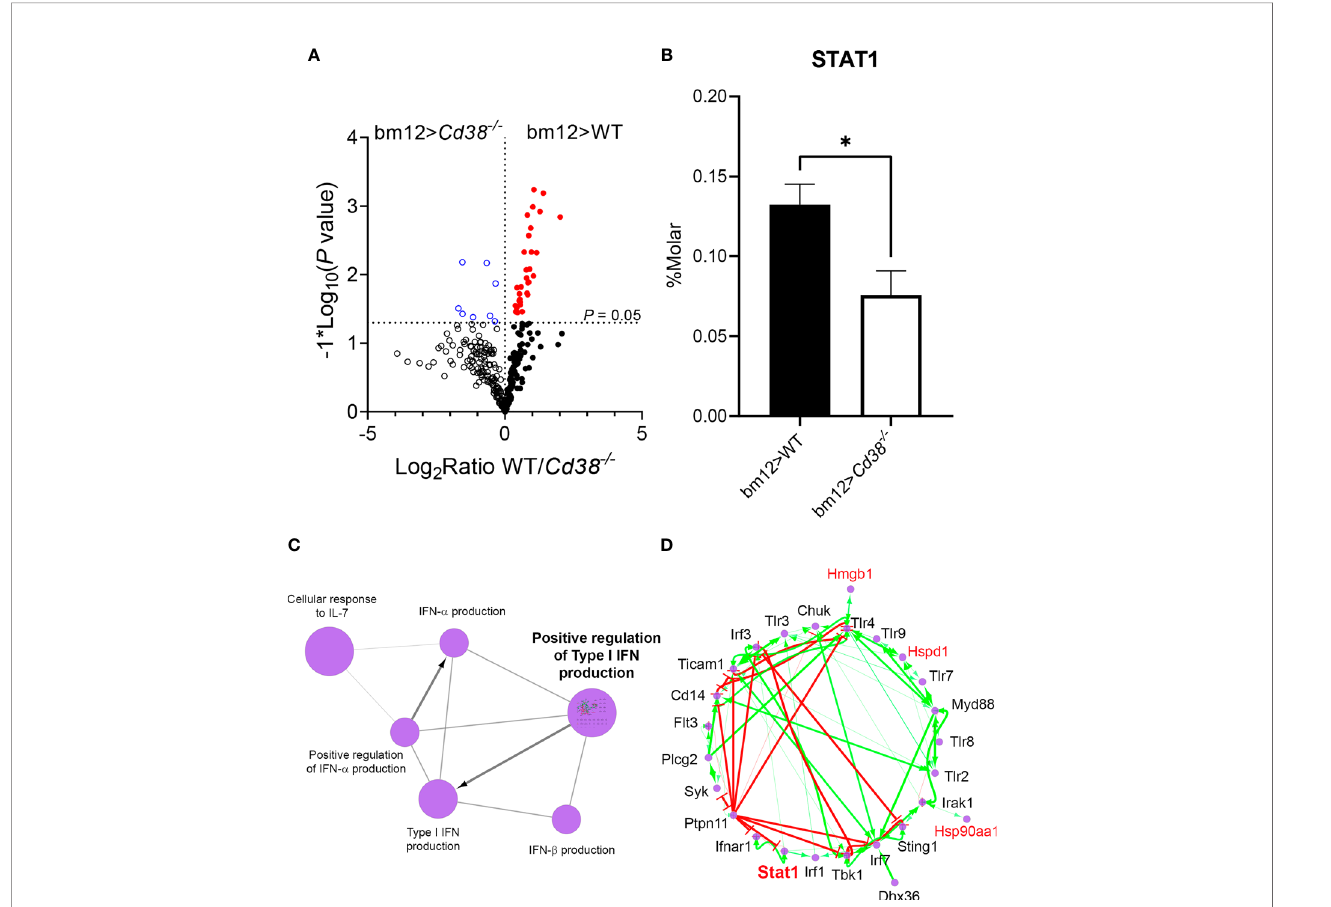
FIGURE 8 | (A) Volcano plots showing the differences in protein abundance in spleens of bm12> Cd38 − / − mice (open blue circles, upper left quadrant) relative to bm12>WT mice (closed red circles, upper right quadrant), 2 weeks after the adoptive transfer. Each circle denotes a different protein, and those above the horizontal dotted line showed statistical signi fi cant differences in abundance between mice. P < 0.05. (B) Histogram graph showing STAT1 protein abundance in spleens from bm12> Cd38 − / − versus bm12>WT mice at 2 weeks. Histograms represent the mean ± SEM, and the P -values are for unpaired t -test. Proteomic data shown in panels (A, B) are from two biological replicas per mouse type and three technical replicas per sample. (C) Functionally grouped network of GO terms/pathways and genes are visualized using the ClueGO/CluePedia application. Note that in this application the protein accession numbers of the identi fi ed proteins are transformed to their gene names. Terms (large purple circles) are linked based on k score ( ≥ 0.3). Edges show the known expression. The edge thickness is scaled between the minimum and maximum scores shown. The size of the terms is related with their statistical signi fi cance. (D) “ Positive regulation of type I interferon production ’” pathway, which showed the highest statistical signi fi cance, was investigated in a subnetwork. Gene names of the identi fi ed proteins are highlighted in red. Genes not included in the initial selection are highlighted in black. Known activation [activation symbols in green (arrows)] and inhibition (inhibitory symbols in red) effects are shown. Stat1 and some of the genes of the identi fi ed proteins (highlighted in red) are acting as activators in this pathway. * P <